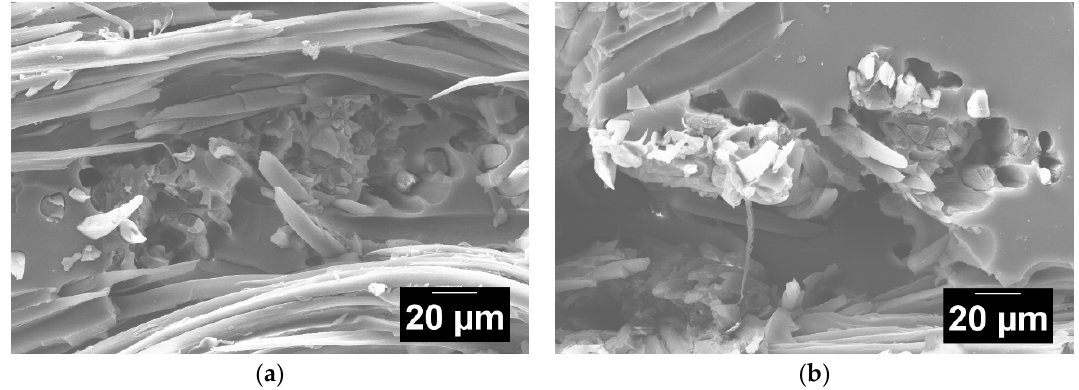
Figure 9. Sample SEM images at 400 × of the fractured surfaces of silk/epoxy laminates fabricated ( a ) without external pressure and ( b ) with external pressure.